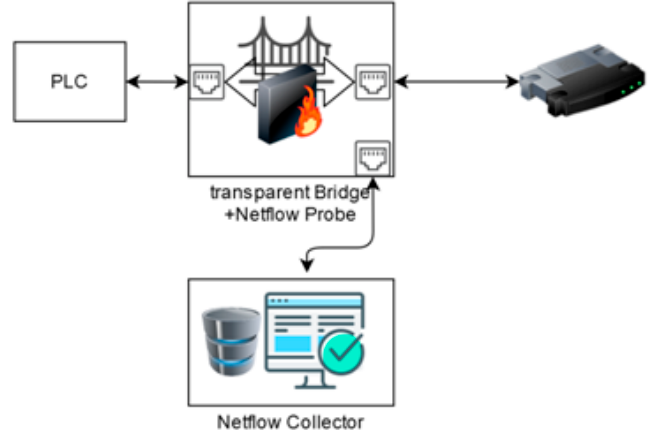
Figure 12. Scheme of net flow data acquisition.